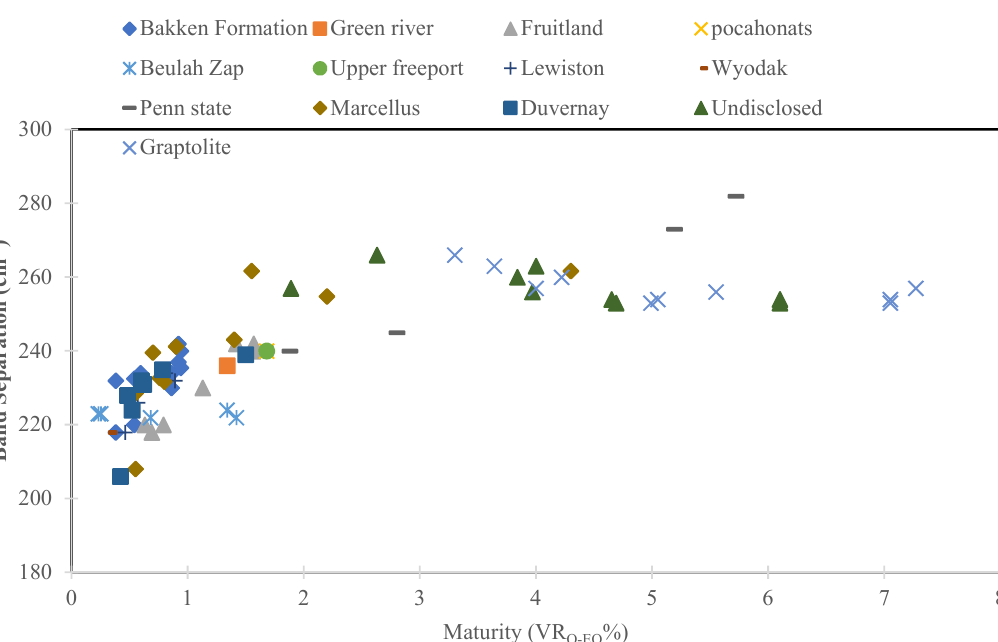
Figure 4. Raman band separation (G-D) vs. maturity (VR O-Eq %) for 13 samples from different geologic regions including the Bakken Formation, Green River, Penn State, Marcellus, Duvernay, and undisclosed Formations. (Data are extracted from other research [64,67,81] acquired by the 532 nm laser